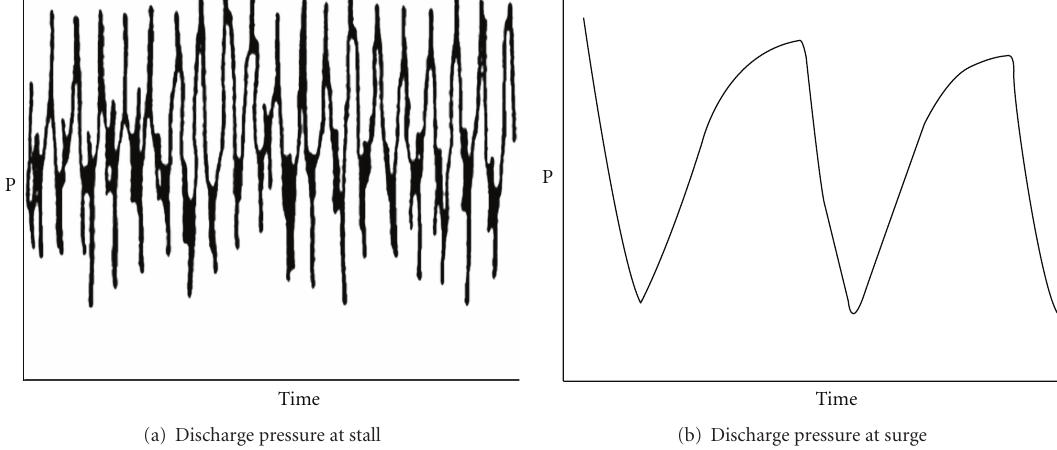
Figure 24: Stall and surge pressure variation with time.